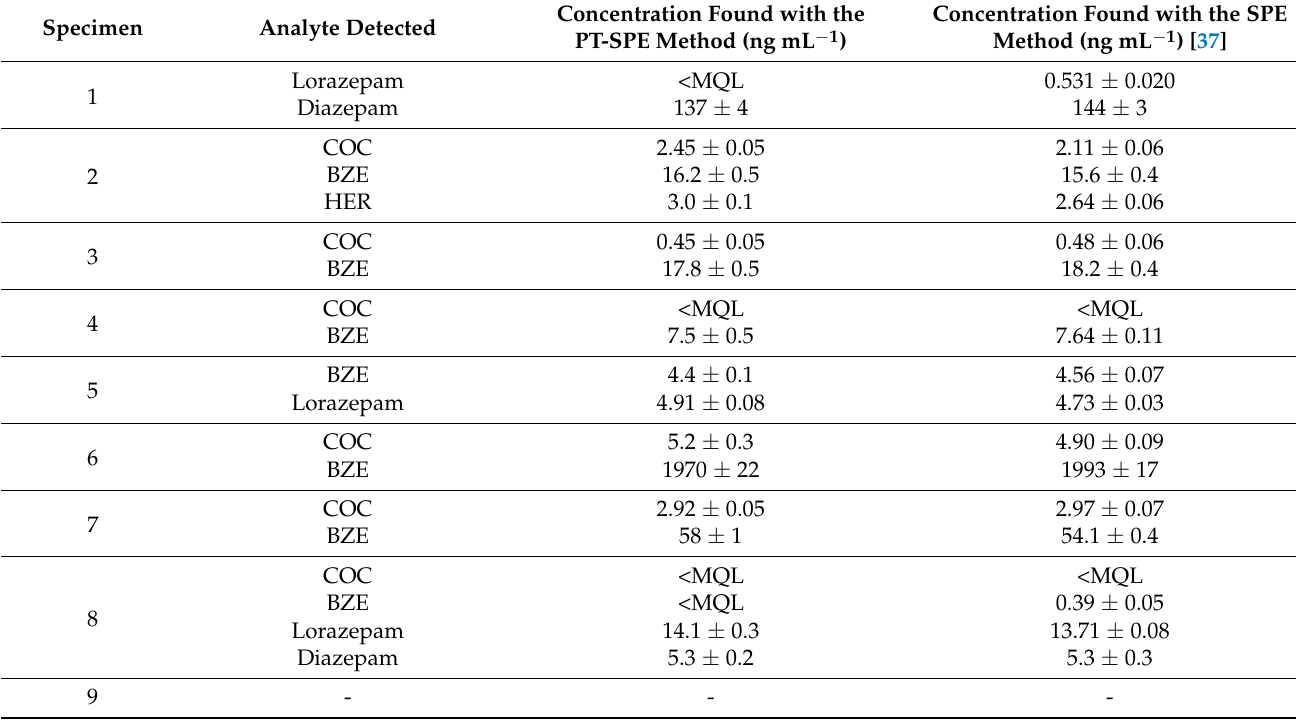
Table 3. Concentration of the DOAs detected in urine samples from women starting a detoxification program and comparison with the SPE